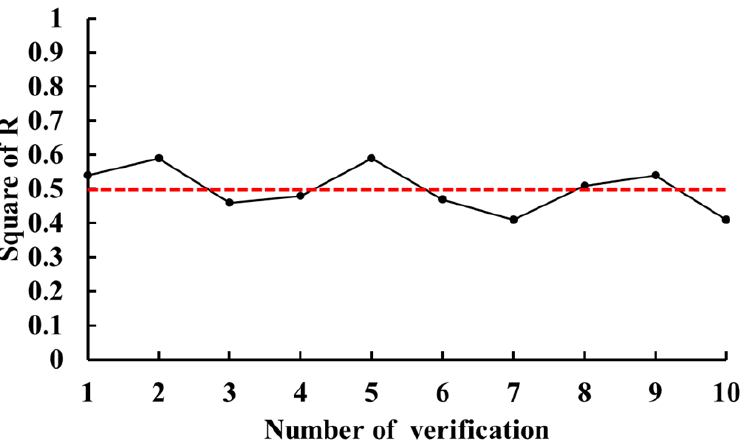
Figure 7. The relationship between the R 2 value and the number of verifications.